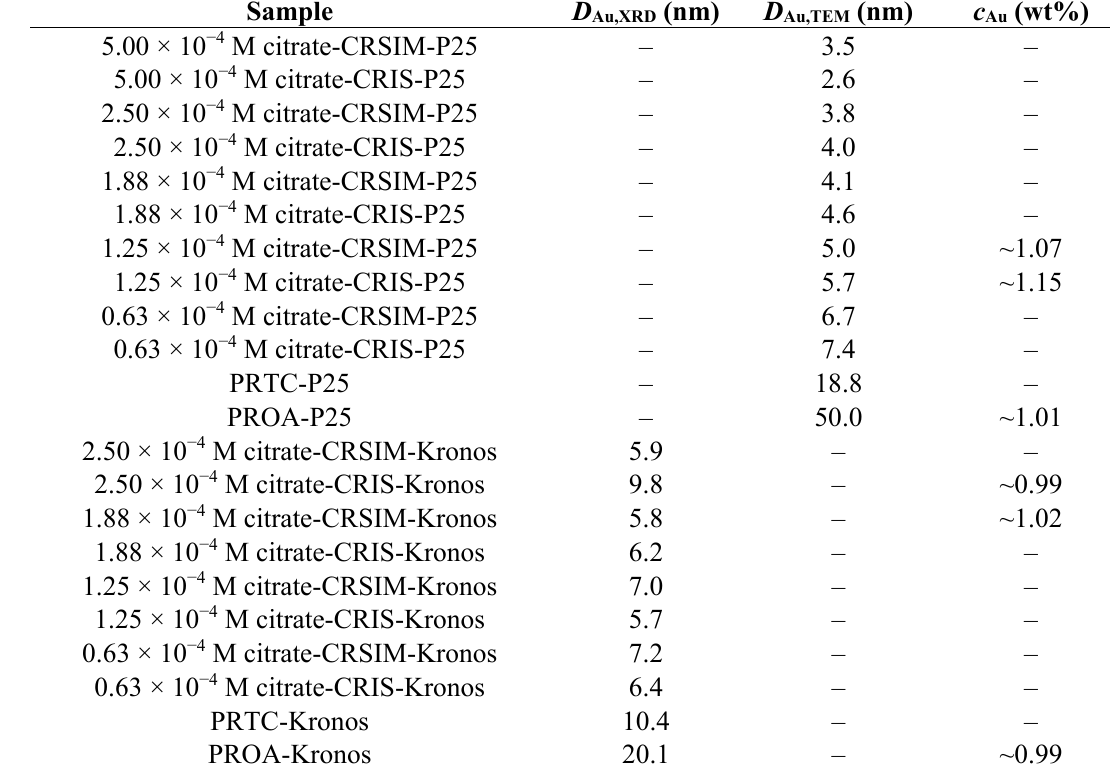
Table 1. Average Au particle diameters on the TiO 2 -based photocatalysts, and Au loading calculated from EDX